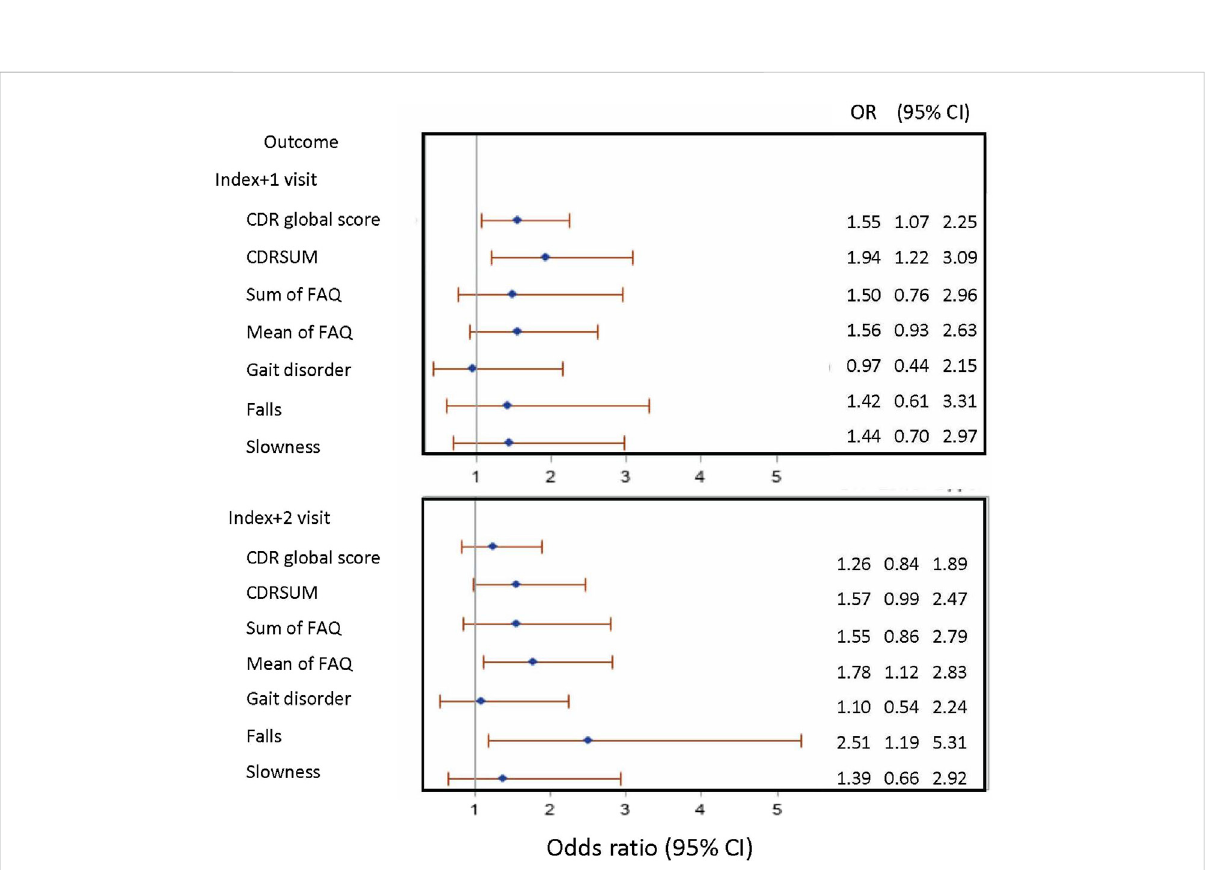
FIGURE 3 Forest plotpresentingtheoddsratio(95%con fi denceinterval)ofoutcomes ofinterestingabapentinnew-userscomparedto non-users. Note: CDR: Clinical Dementia Rating; CDRSUM: Clinical Dementia Rating sum of boxes; FAQ: Functional Activities Questionnaire; OR: odds ratio; CI: con fi dence